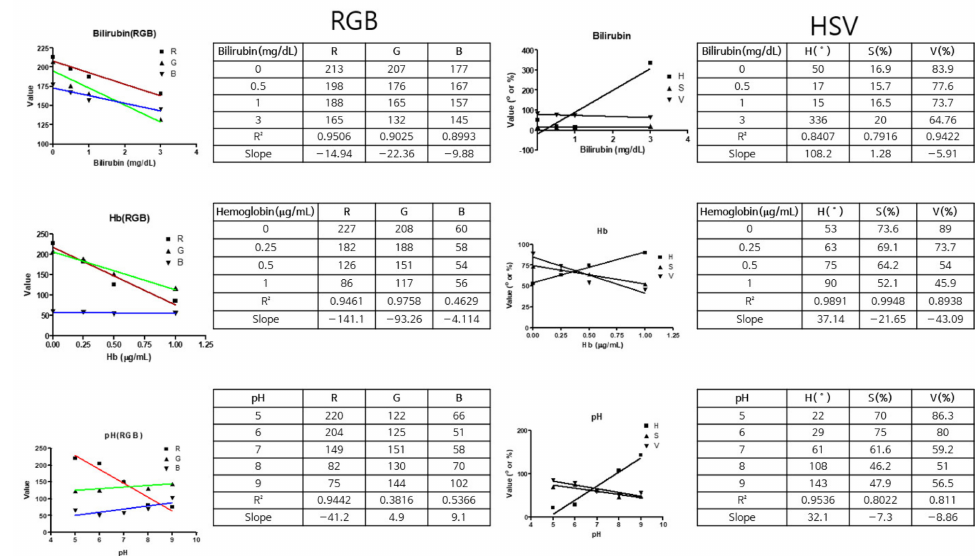
Figure 4. Comparison of RGB and HSV values for Bilirubin, Hb, and pH. (The values were extracted and compared using GraphPad software; an iPhone 11 pro was used as the